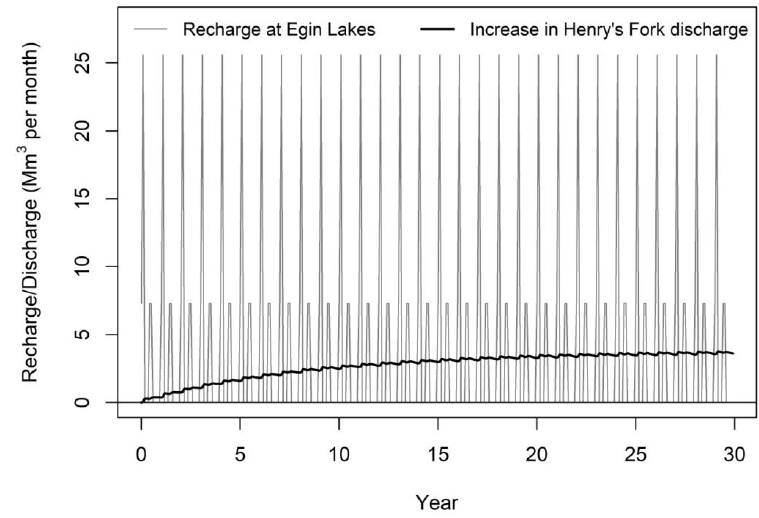
Figure 4. Recharge and discharge for annual MAR scenario of 7.3 Mm 3 per month in each of March, April, and October, and 25.6 Mm 3 per month in November, repeated every year for 30 years. Water 2020 , 12 , x FOR PEER REVIEW